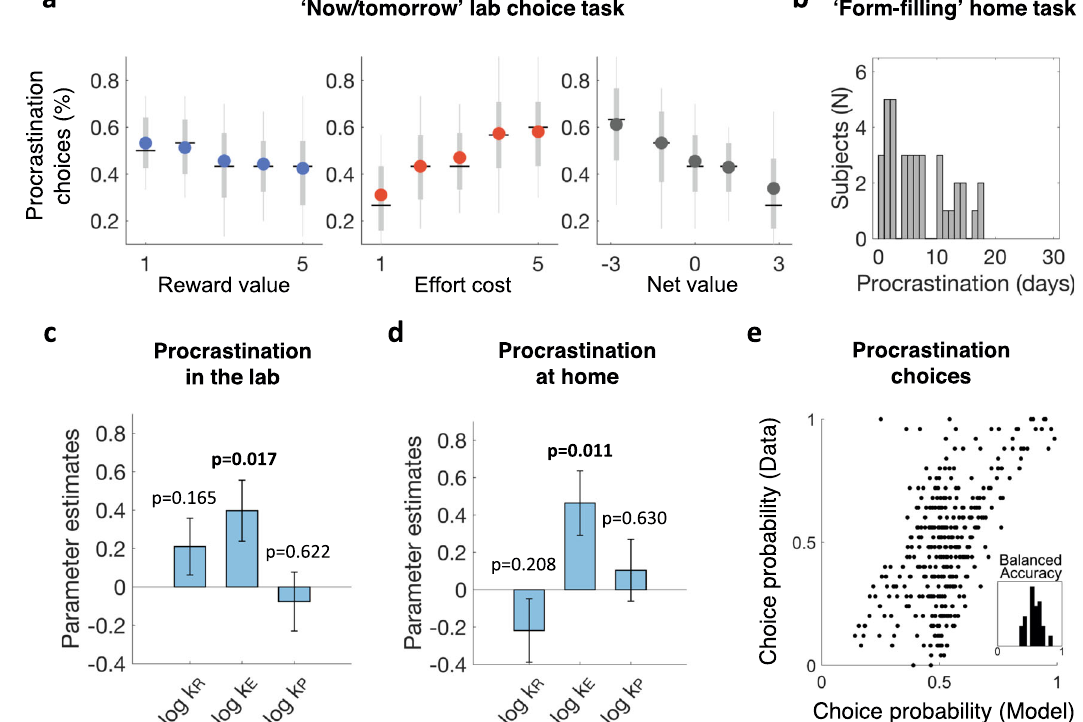
Fig. 4 | Explaining procrastination with time preferences. a Procrastination behavior in the lab ‘ now/tomorrow ’ choice task. Plots show choice rates for the ‘ tomorrow ’ option as a function of reward value (left), effort cost (middle), or the task net value (right). On each dot plot, the color mark indicates the mean, the horizonalline indicatesthe median, the thickwhiskers indicate the range from25th to 75th percentiles, and the thin whiskers indicate the range from 5th to 95th percentiles. ( n =43). Source data are provided as a Source Data fi le b Procrastination behavior in the at-home ‘ form- fi lling ’ task. Histograms show the distributionofthedelaybeforeparticipantscompletedandreturnedadministrative forms. c Regression estimates of the temporal discount rates for reward ( k R ), effort ( k E ) and punishment ( k P ) obtained from fi tting a linear model (also including age and gender) to procrastination level in the ‘ now/tomorrow ’ choice task. Error bars representSD;signi fi cancevaluesarebasedontwo-tailedone-sample t tests( n =43).